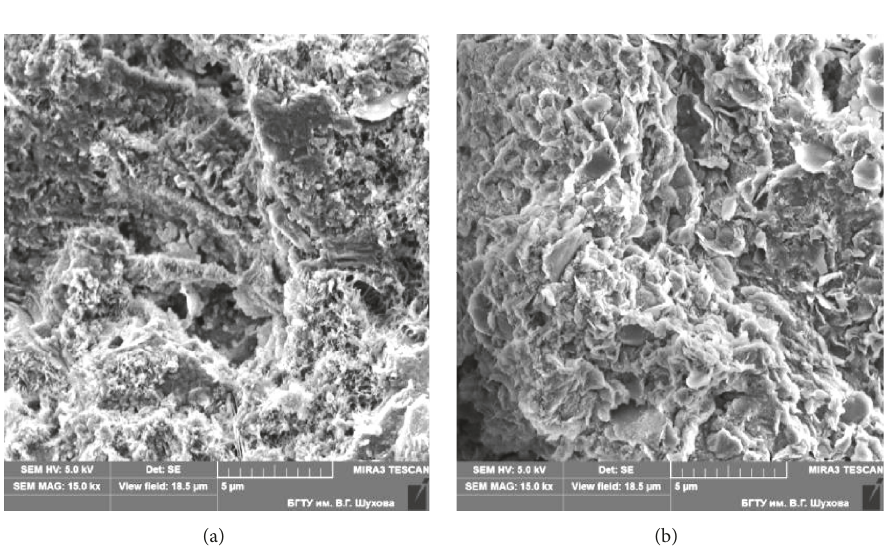
Figure 8: The neoplasms micrographs: (a) cement stone without any additives; (b) cement stone based on composite binders.